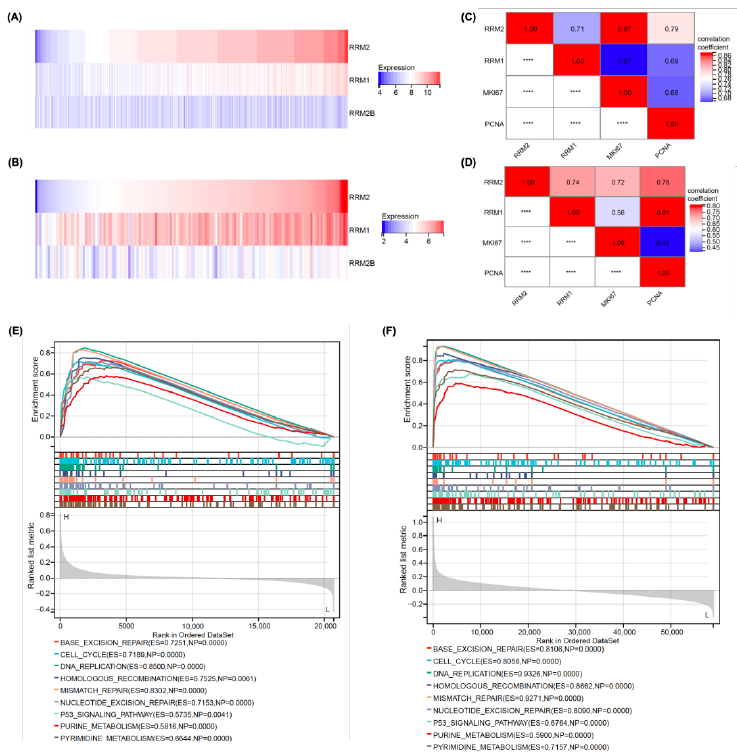
Figure 1. Analyses of RRM2 expression in samples from patients with AML from the GEO and TCGA databases. ( A , B ) Heatmaps showing the expression profiles of RRM1, RRM2, and RRM2B in patients with AML. ( C , D ) Correlation analyses between the expression of RRM2 and RRM1 with the cell proliferation biomarkers KI67 and PCNA in patients with AML. ( E , F ) KEGG enrichment plots constructed using GSEA for the RRM2 high expression group of patients with AML. Data in ( A , C , E ) were obtained from GSE147515 (N = 1534); data in ( B , D , F ) were obtained from TCGA ( n = 151). **** is a mirror image of the chart and has no special meaning .